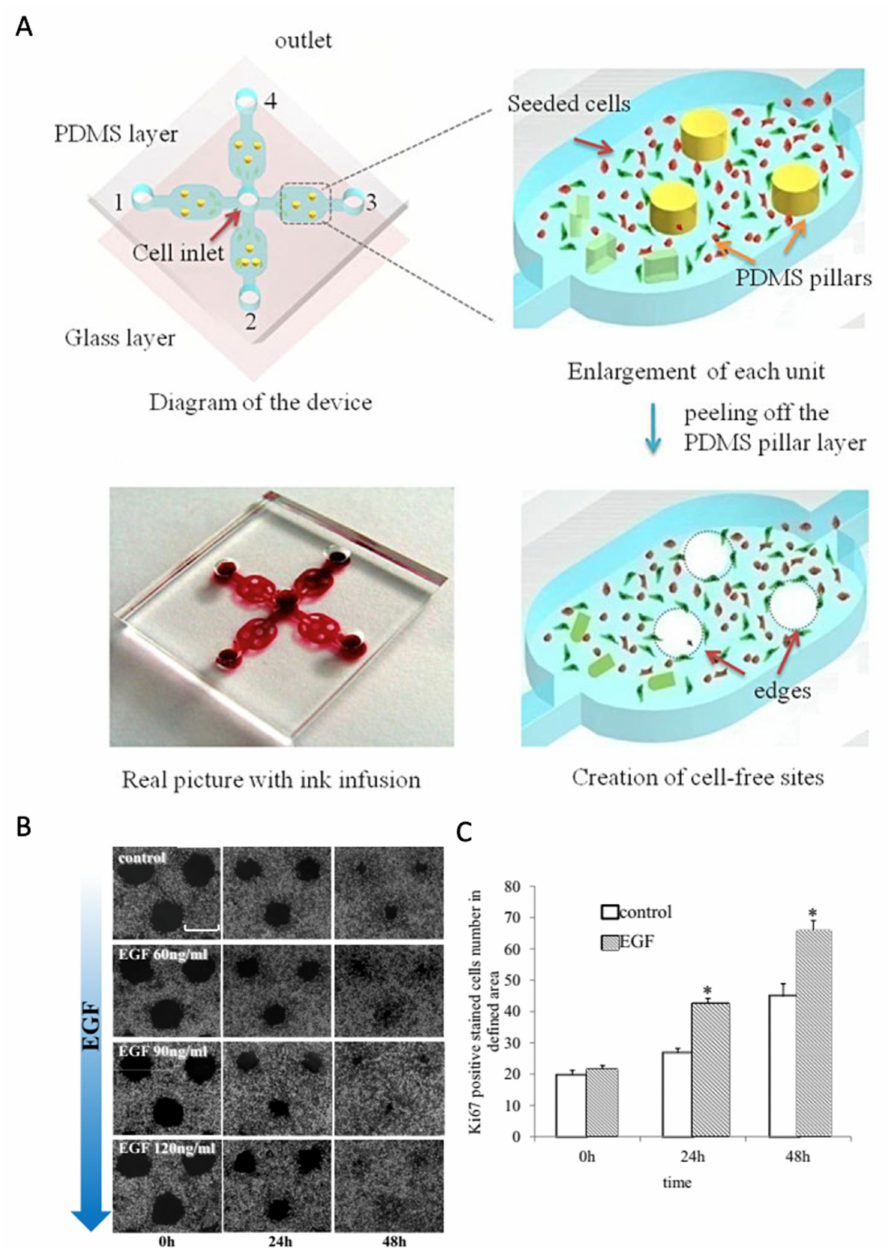
Figure 4. Microfluidic wound healing assays based on physical cell exclusion. ( A – C ) Pillar-based microfluidic wound healing to analyze the influence of ( B ) EGF concentration on wound closure and ( C ) the number of proliferative cells. (* p < 0.05 vs. control). Adapted with permission from ref. [28]. 2021,